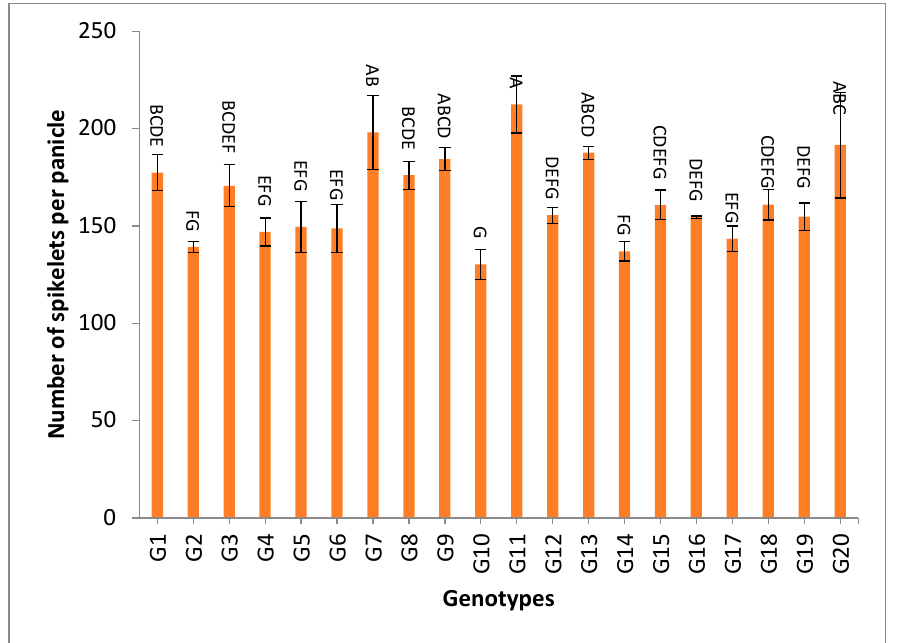
Figure 5. The mean numbers of spikelets per panicle of twenty rice genotypes over the two years. Bar represents the standard deviation. Different alphabetic letters represent the significant differences among the genotypes at p < 0.05, based on Duncan’s multiple range test.